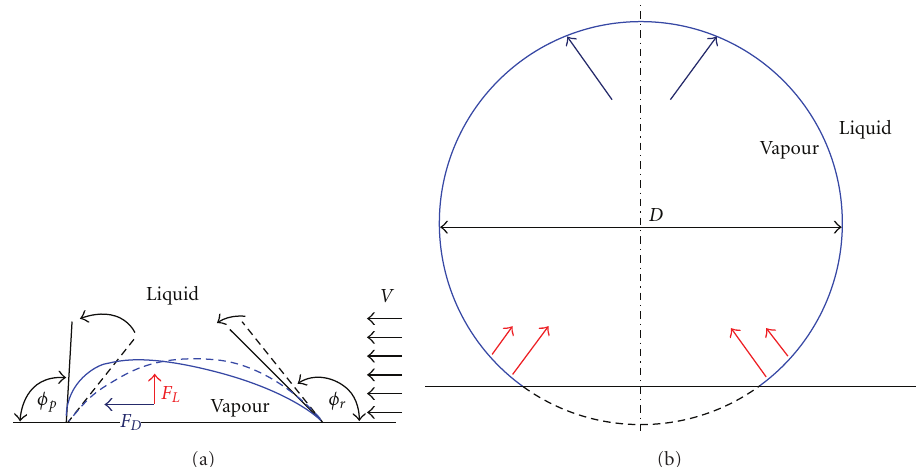
Figure 3: Demonstration of a drag force and a lift force acting on a vapour slug (a), and momentum change due to the evaporation and condensation on the liquid vapour interface within the bubble (b).